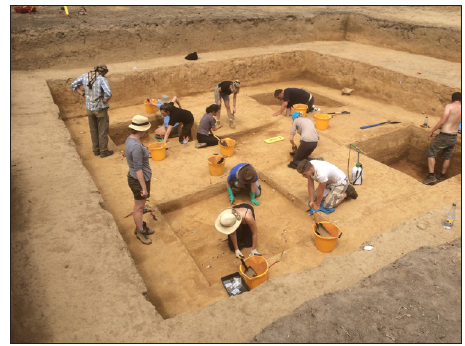
Figure 5: Fieldwork at Les Varines, Jersey (Photo Matt Pope).